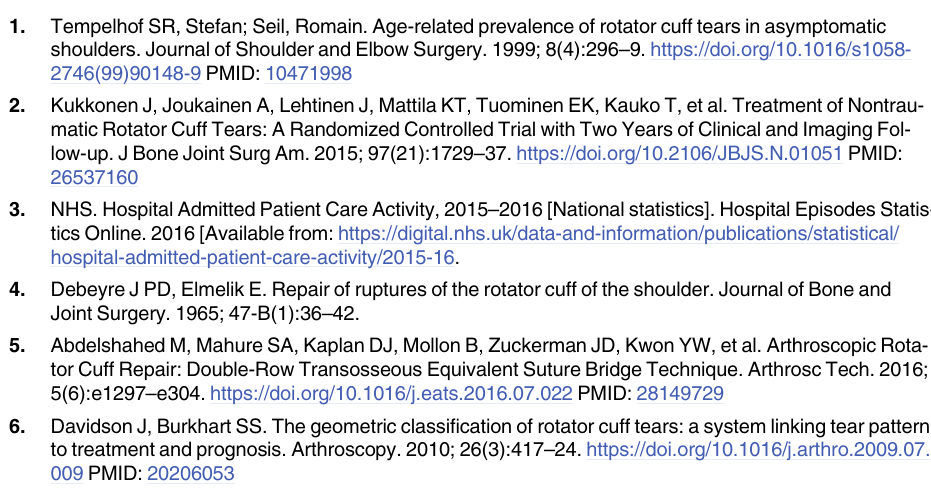
S1 Table. Results of circumference measurements (in cm) of the right forelimb of the sheep taken above and below the ergot pre-surgery and pre-necropsy, 3 months post-sur- gery. S2 Table. Results of full blood count and serum inflammatory markers taken pre-surgery and pre-necropsy, 3 months post-surgery. WBC: White Blood Cells, Neut: Neutrophils, Lymph: Lymphocytes, RBC: Red Blood